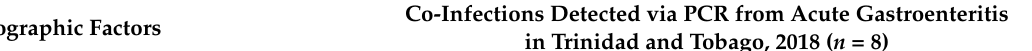
Table 2. Co-infections detected via PCR panel from acute gastroenteritis patients in Trinidad and Tobago,